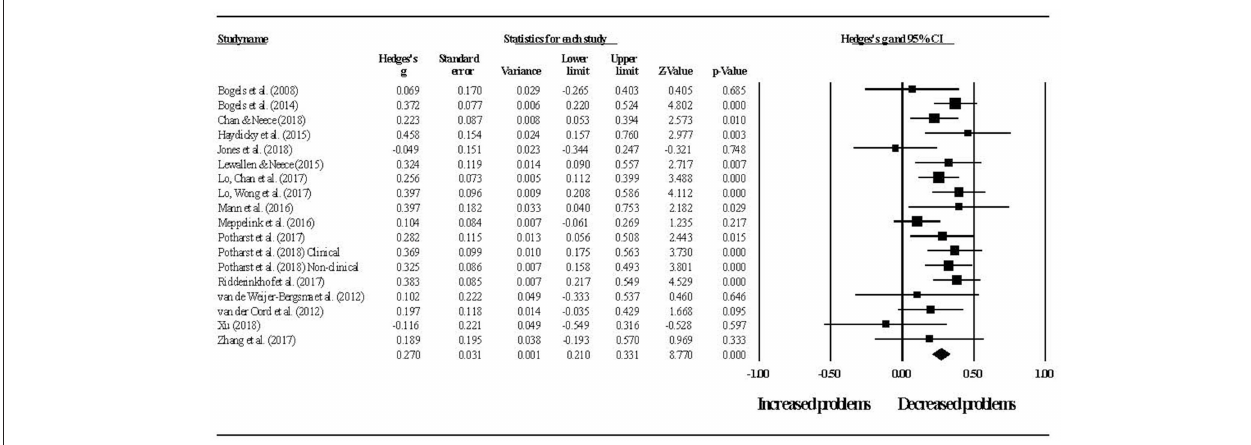
FIGURE 3 | Pre- to post-intervention change in overall youth